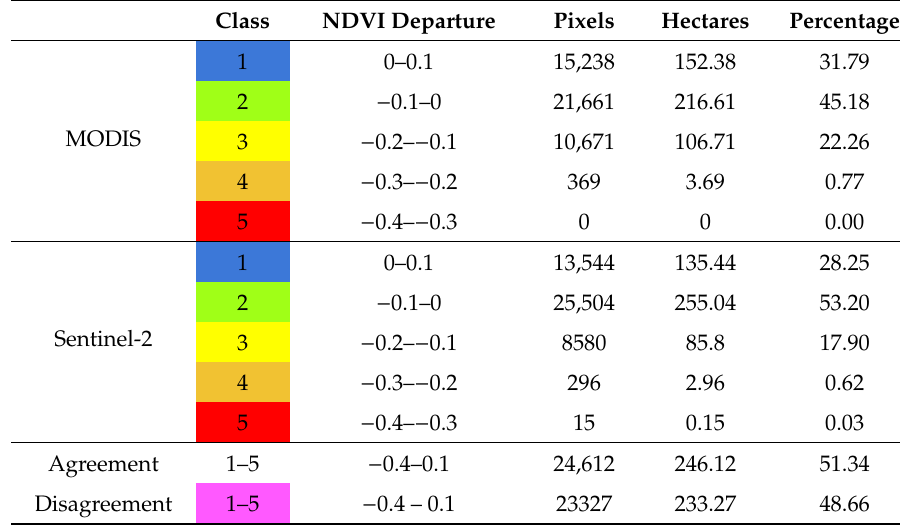
Figure 2. Comparison of bark beetle detection data in three forest stands with active Ips bark beetle spots in 2019. Each column of images shows the same stand, from top to bottom, aerial survey photograph, Moderate Resolution Imaging Spectroradiometer Normalized Difference Vegetation Index (MODIS NDVI) change product, Sentinel-2 NDVI change product, and px of disagreement between MODIS and Sentinel-2 products. Colors correspond to classification of NDVI departure and disagreement. Blue corresponds to positive changes in NDVI values. Colors green, yellow, orange, and red, correspond to negative NDVI departure values. Pink corresponds to disagreement between MODIS and Sentinel-2 images. Table 2. Assessment of the NDVI change products from MODIS and Sentinel-2 in stands with confirmed Ips spots. Class colors correspond to classification of NDVI departure and disagreement. Blue corresponds to positive changes in NDVI values. Colors green, yellow, orange, and red correspond to negative NDVI departure values.